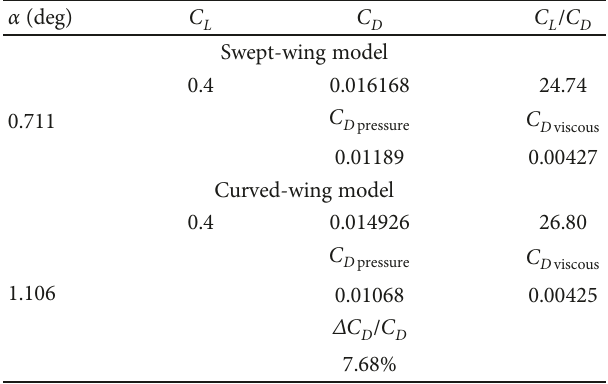
Figure 13: E ffi ciency of wings ( M = 0 85 , h = 10,000m Table 2: Estimation of drag reduction ( M = 0 85 , h = 10,000m , C L = 0 4 , and 6 5 × 10 6 cells).